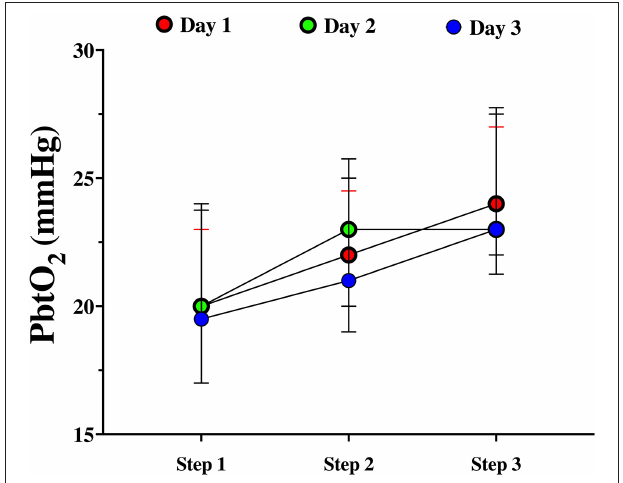
FIGURE 3 | PbtO 2 changes during the CPP challenge over the first 3 days of